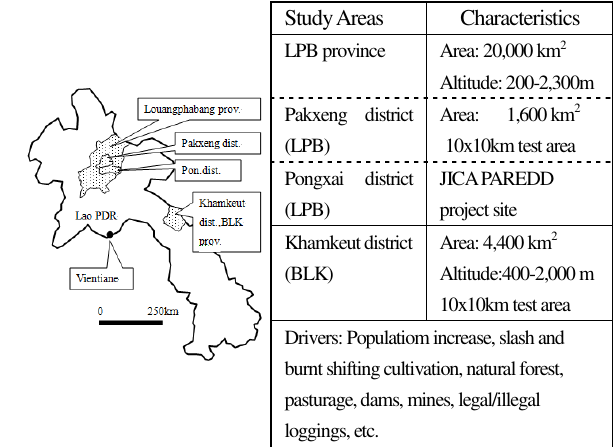
Figure 1. Locations and characteristics of the pilot study areas in Louangphabang (LPB) and Bolikhmxai(BLK) provinces in Lao